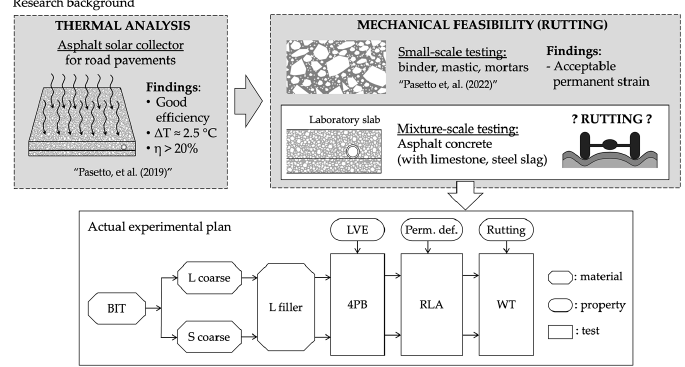
Figure 1. Global research framework and experimental plan [31,32].